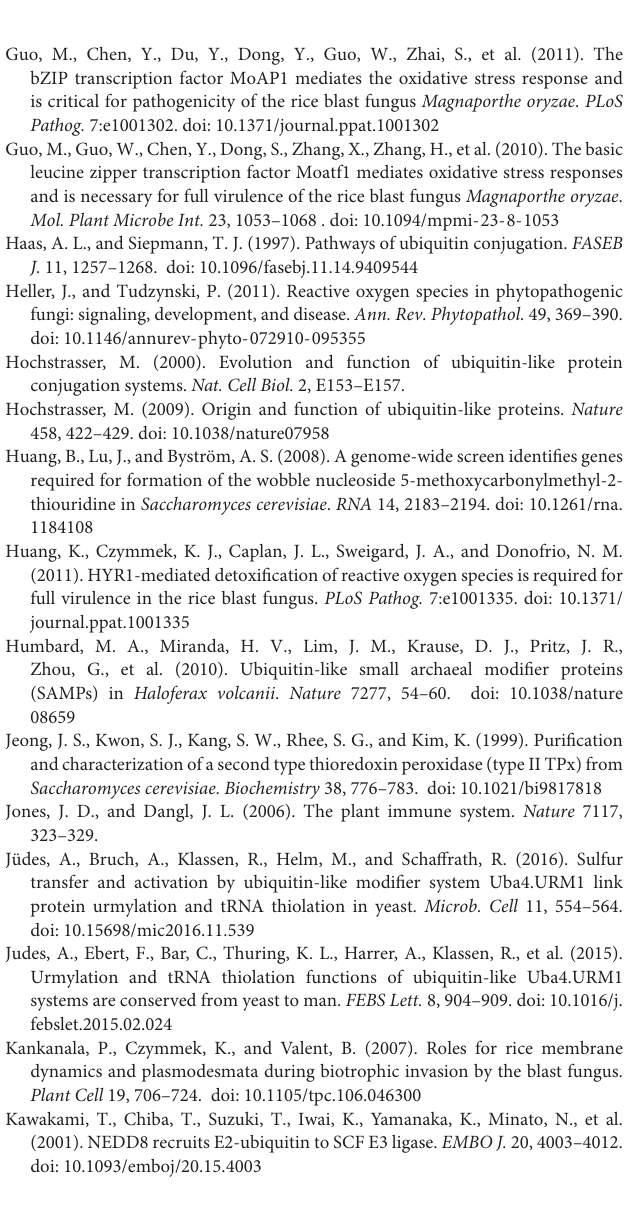
FIGURE S1 | Phase specific expression of URM1 . FIGURE S2 | Replacement of URM1 in M. oryzae . FIGURE S3 | Appressorium formation rates of the wild type, (cid:49) urm1 mutant and complemented strains. TABLE S1 | Strains used in this study. TABLE S2 | Vectors used in this study. TABLE S3 | Primers used in this